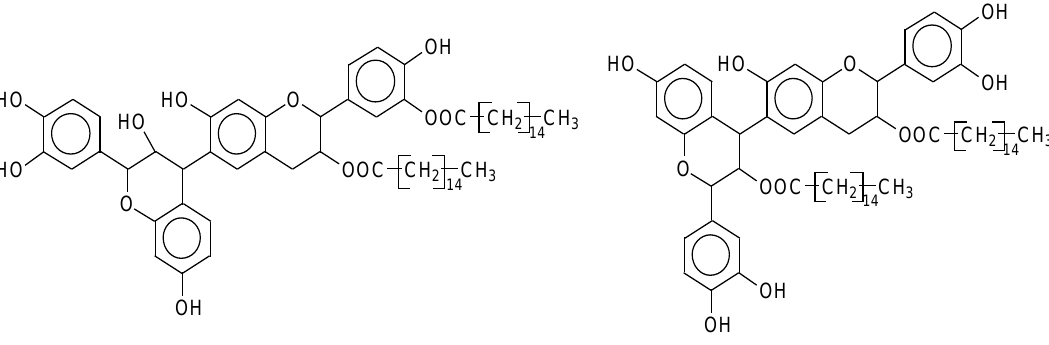
Figure 4. Two of the possible isomer structures for the (fisetinidin) 2 -(palmitate) 2 oligomer, showing that the palmitoyl residue can have reacted both on the C3 alcoholic – OH and on one of the phenolic – OHs. phenolic –OHs.